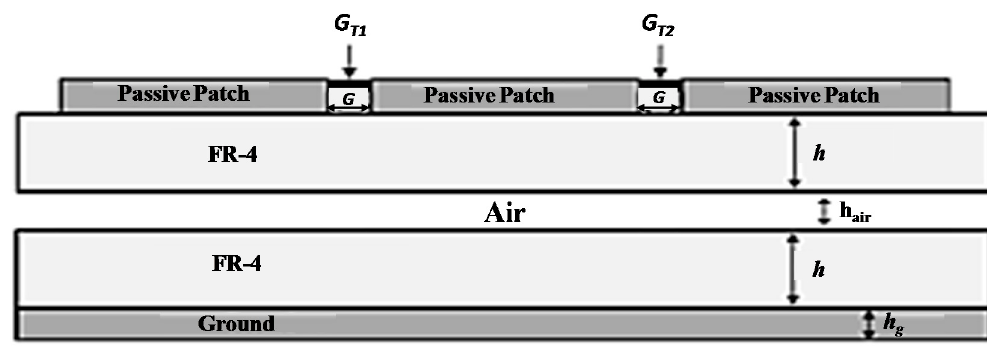
Figure 5. Corss-section view of the P-ESPAR antenna.